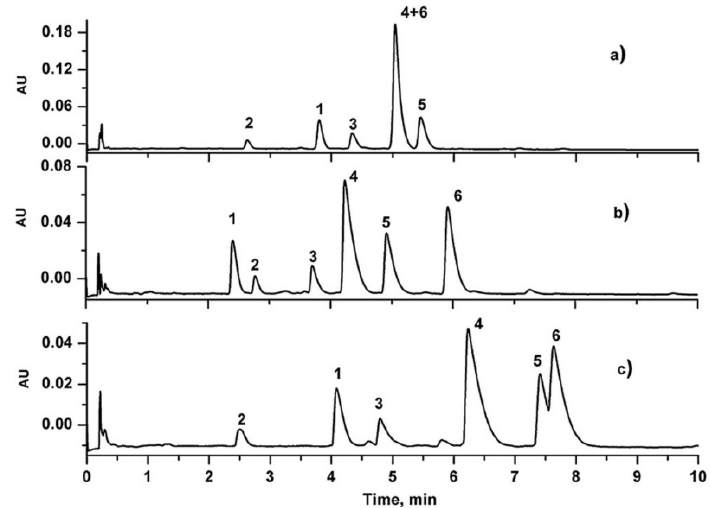
Figure 1. Optimization of stationary phases for six standard alkaloids separation. ( a ) BEH, ( b ) BEH 2-EP, and ( c ) CSH PFP columns. Analytes: (1) compound 1, (2) euonymine, (3) wilfornine D, (4) wilforgine, (5) wilforine, and (6) hyponine E. Adapted from [31] with permission. Copyright 2015, Elsevier.